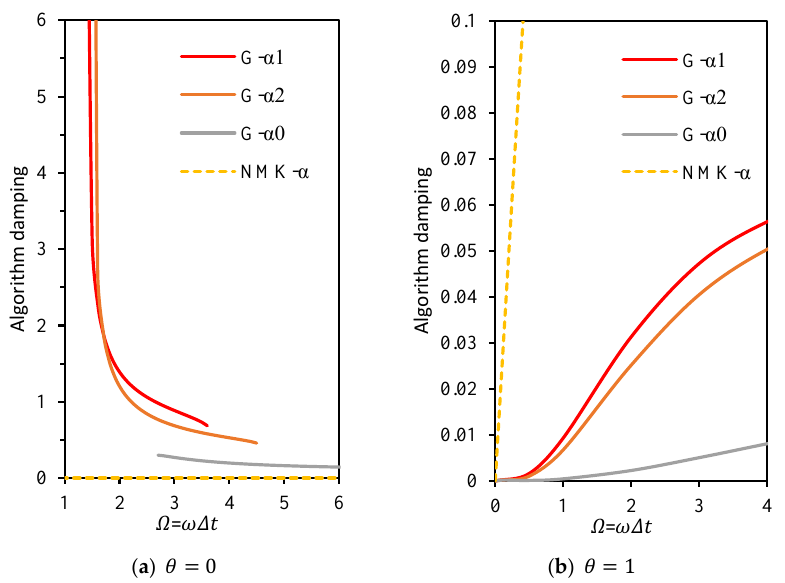
Figure 7. Algorithm damping ζ̅ of the referred methods: ( a ) 𝜃 = 0 by the sampling frequency 𝛺 ; ( b ) 𝜃 = 1 by the sampling frequency 𝛺 .